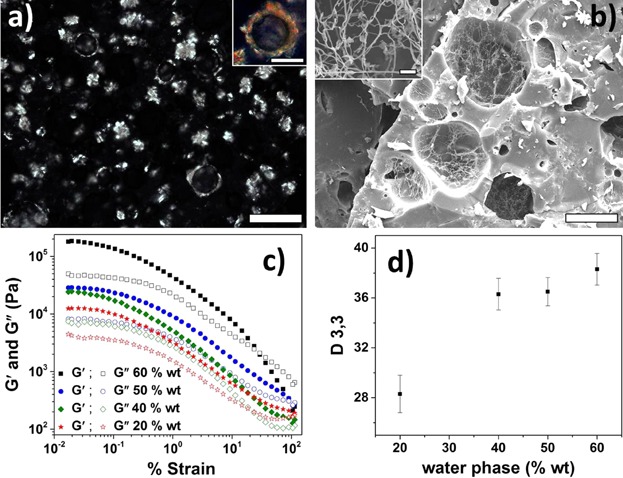
(a) PLM image of emulsion showing water droplets and wax crystals (scale bar = 50 μm), inset: magnified image of water droplet showing the presence of crystal at droplet interface (scale bar = 25 μm); (b) cryo-SEM image of freeze-fractured emulsion sample (scale bar = 25 μm), inset: magnified image of the network of fine crystallites left after the removal of dispersed water through sublimation (scale bar = 200 nm); (c and d) comparative rheology and mean droplet sizes, respectively, of emulsion formed at water phase levels of 20–60 wt%).